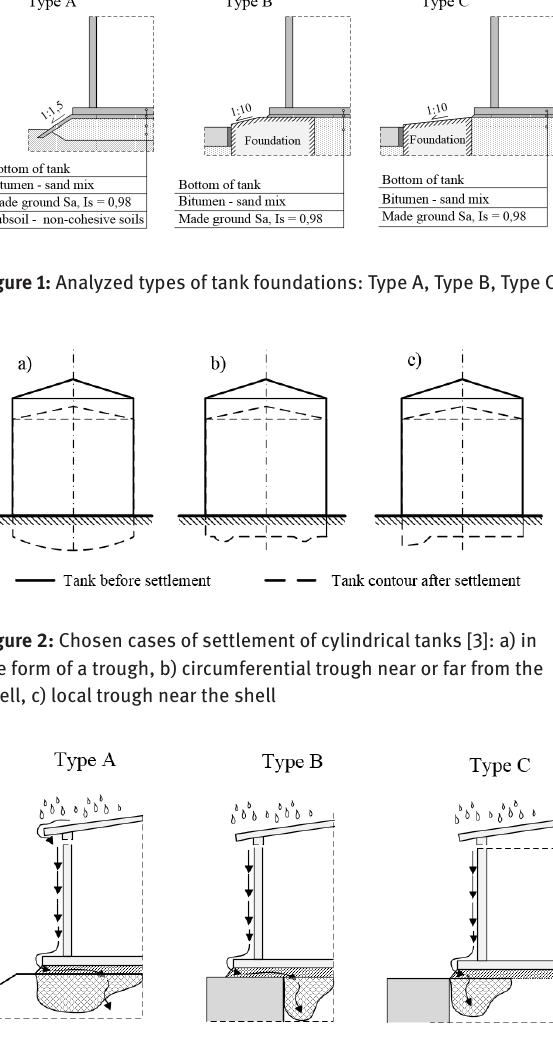
Figure 3: Penetration of rainwater under the bottom of tanks: Type A, Type B, Type